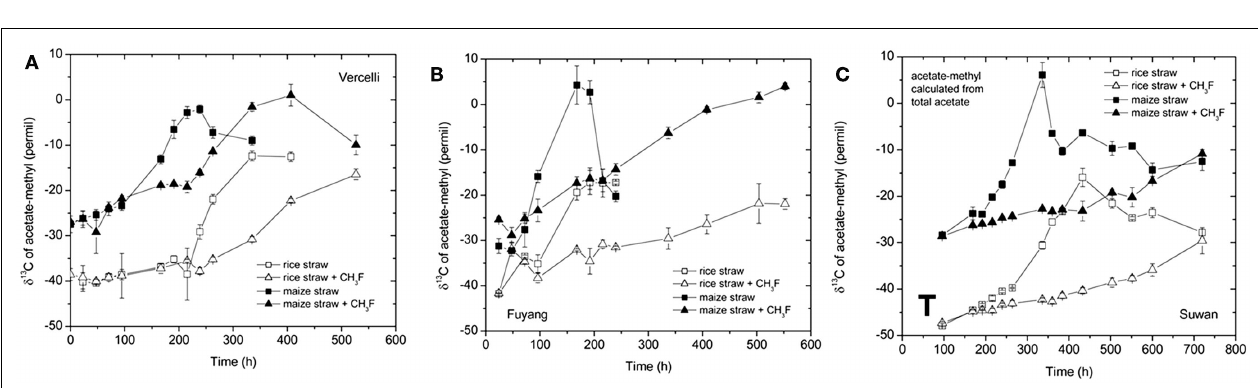
FIGURE 4 |Values of δ 13 C of the CH 4 accumulated in soil from (A)Vercelli, (B) Fuyang, and (C) Suwan, amended with either rice straw or maize straw and incubated under anoxic conditions in the absence or presence of CH 3 F (1, 2, and 2% inVercelli, Fuyang, and Suwan soil, respectively); mean ± SE, n = 3 .